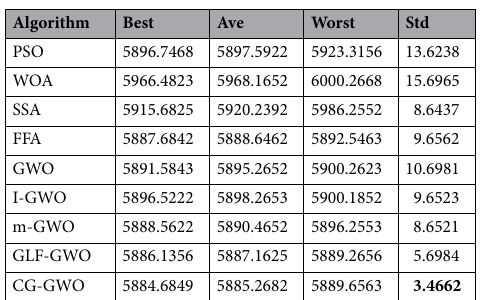
Table 9. Statistical results of CG-GWO and other optimization algorithms for the pressure vessel design problem. Significant values are in bold.